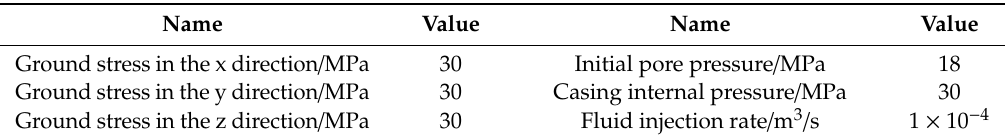
Table 3. The load data.